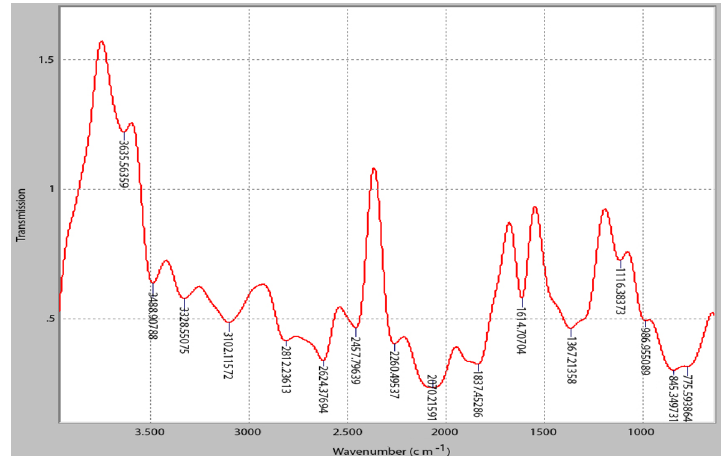
Figure 5. FTIR spectra on active PNSC.